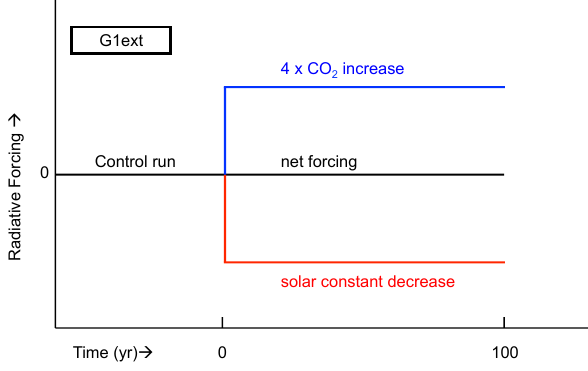
Figure 1. Schematic of experiment G1ext. The experiment is started from a preindustrial control run. The instantaneous quadrupling of the CO 2 concentration from its preindustrial value is balanced by a reduction in solar irradiance for 100